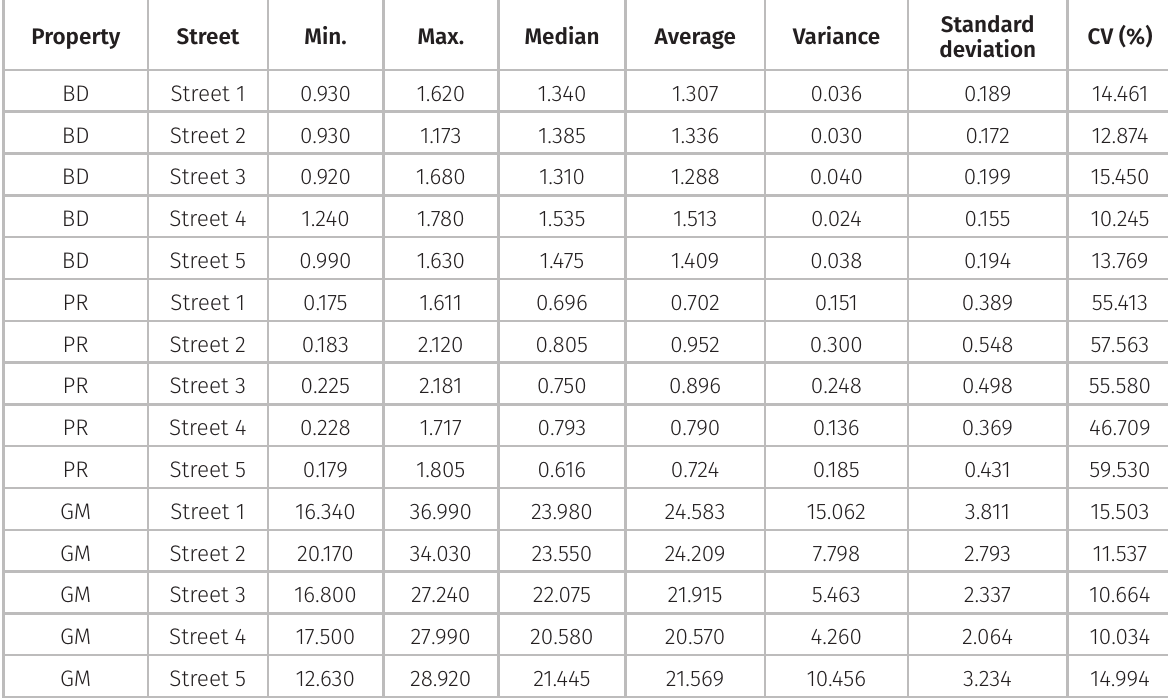
Table I. Results of the descriptive analysis for BD (g cm-3), PR (MPa) and GM (%), for the five coffee streets.